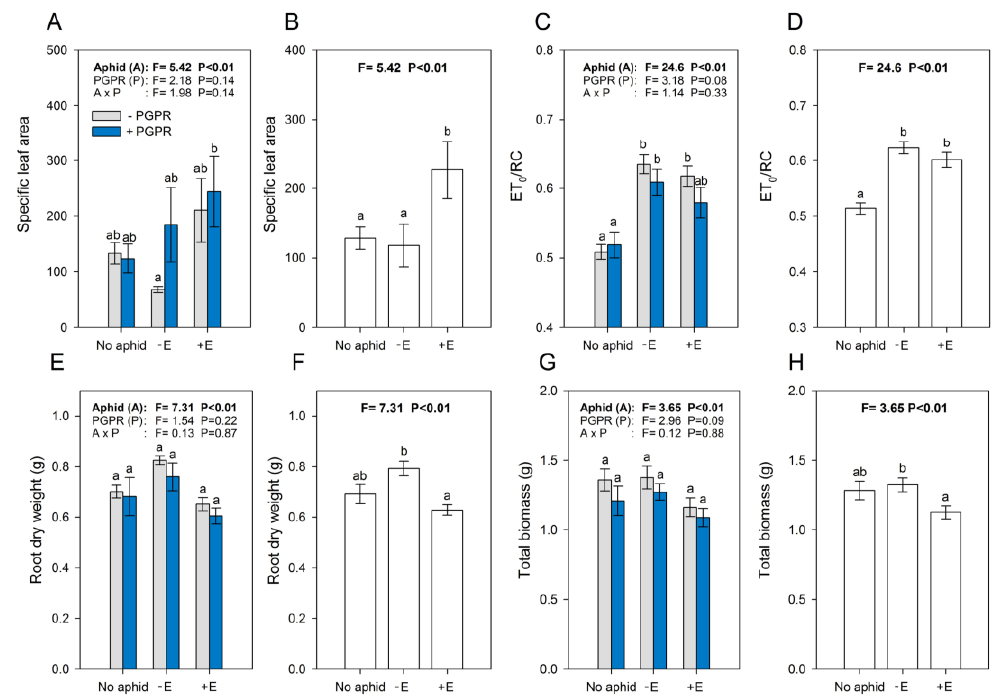
Figure 3. The responses of plants inoculated or not inoculated with B. amyloliquefaciens ( + PGPR and − PGPR, respectively) and infested or not infested by − E and + E A. pisum aphids (absence and presence of the endosymbiont H. defensa , respectively). Panels ( A , C , E , G ); and ( B , D , F , H ) show all e ff ects (aphid, PGPR, and interaction) and aphid e ff ects (as the only significant in all cases), respectively. The di ff erent letters indicate significant di ff erences between groups (Tukey’s HSD, p < 0.05). Error bars represent the standard error of mean (n = 9 for the ET 0 / RC; n = 6 for others).